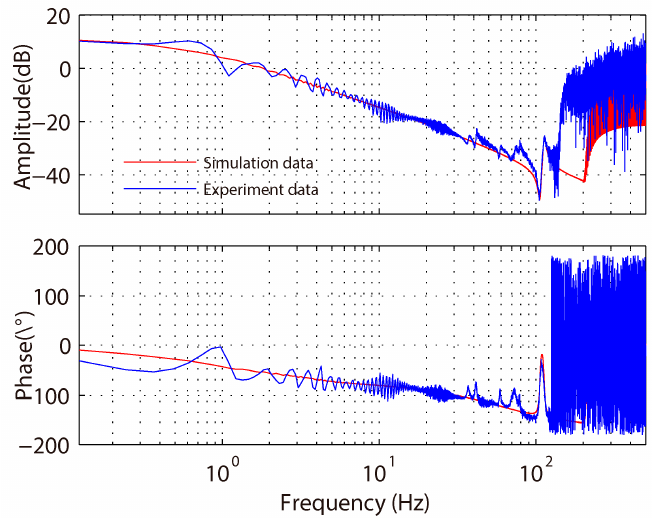
Figure 4. Frequency characteristic fitting curve of model identification.